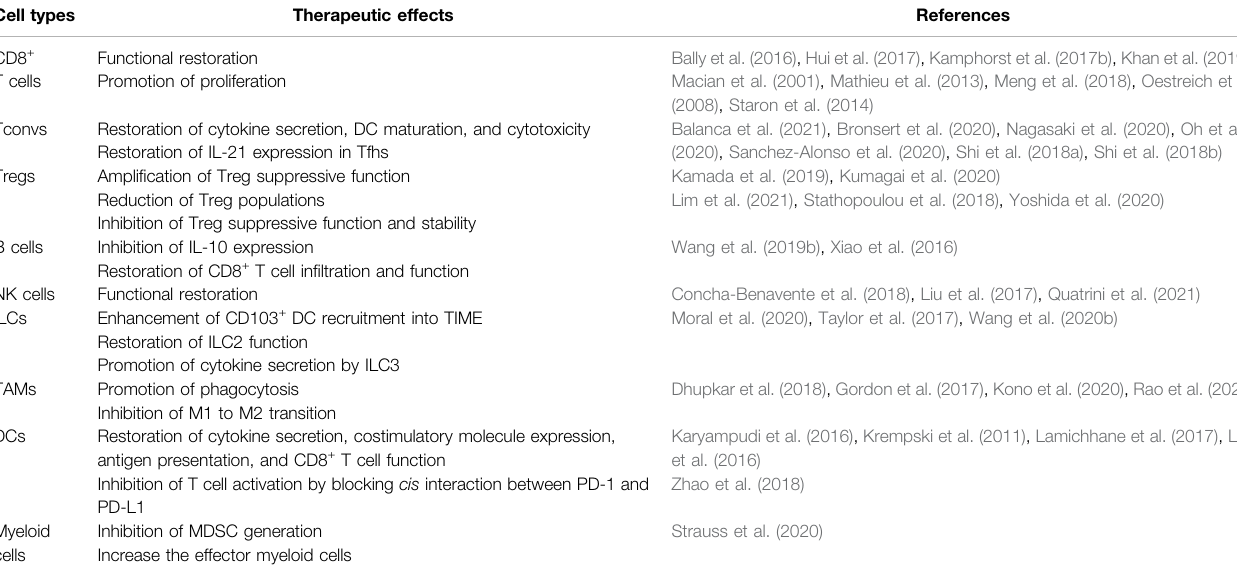
TABLE 2 | The therapeutic effects of PD-1 therapy in various immune